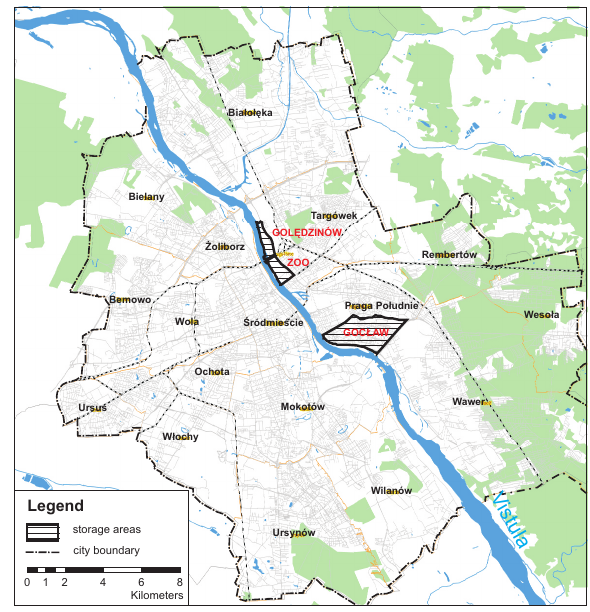
Fig. 1. Study area – Warsaw reach of the River Vistula – breaching test locations (Goclaw, ZOO, and Goledzinow).